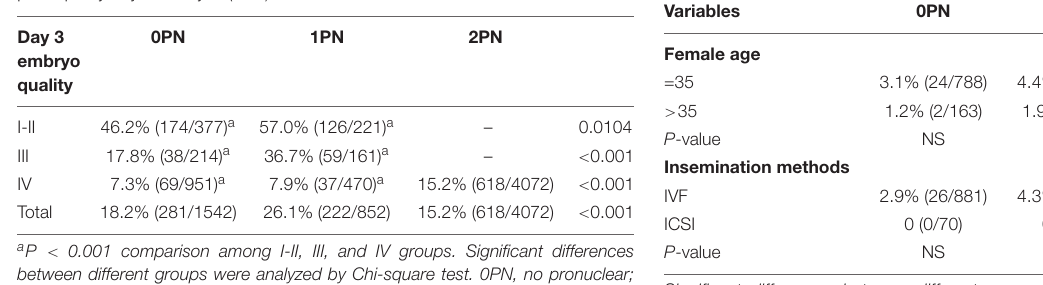
TABLE 1 | Total blastulation rate of abnormal fertilized (0PN and 1PN) and poor-quality day 3 embryos (2PN).